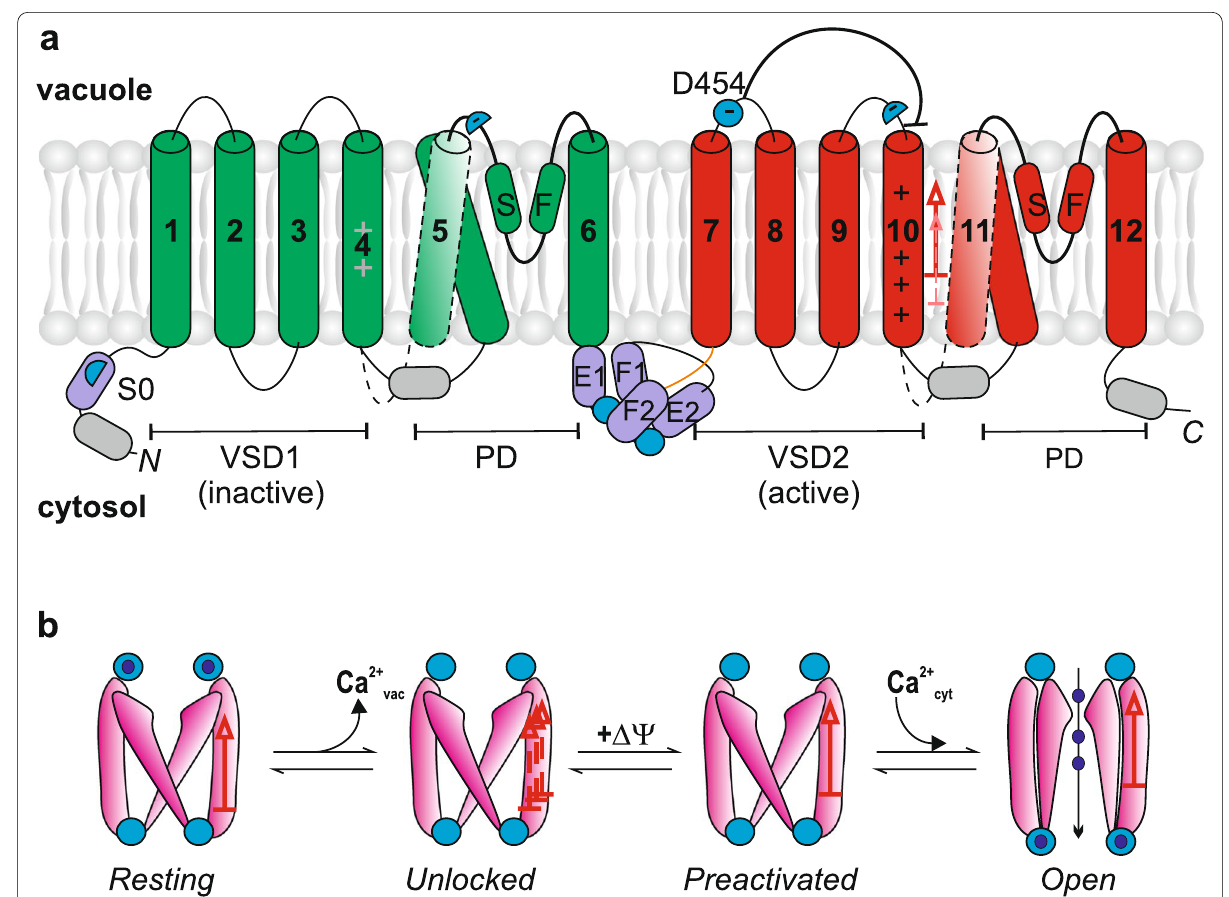
Fig. 1 Topology and gating scheme for the plant TPC1. a Plant TPC1 consists of the two 6-TM domains (membrane helices are numbered from 1 to 12). Each 6-TM domain can be divided into voltage-sensing (VSD) and pore domains (PD). SF is the selectivity filter. E1,2 and F1,2 are parts of cytosolic Ca 2 + binding EF-hands. Two negative residues (Asp) in S0 likely form a part of the Ca 2 + -coordination site together with EF2; Ca 2 + − binding of this site is transmitted to the dilation of the cytosolic mouth and pore opening, providing the VSD2 is in the upper position. Critical residues, responsible for the channel inhibition by vacuolar Ca 2 + are shown in blue; D454 is an Asp residue, whose mutation is responsible for the fou2 mutation, insensitive to luminal Ca 2 + . b A minimal scheme, depicting the sequence of events, leading to the TPC1 opening. At the first step the luminal Ca 2 + ions are removed, unleashing the VSD2 movements. Application of cytosol positive voltage stabilizes the VSD2 in the upper position; in this configuration the channel is able to bind cytosolic Ca 2 + . Finally, binding of cytosolic Ca 2 + promotes the channel